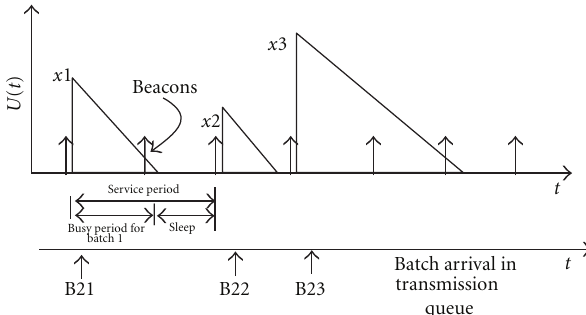
Figure 4: Batch arrival process in STA1 queue for a single peer. B21 denotes the first batch for STA2. Similarly B23 is the third batch for STA2.